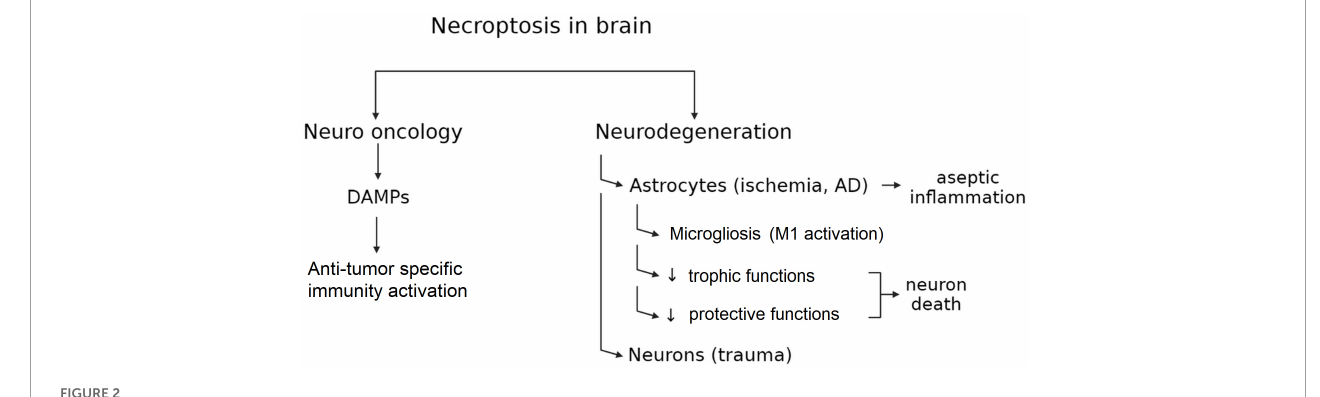
FIGURE2 Double-Edged sword of necroptosis in CNS.